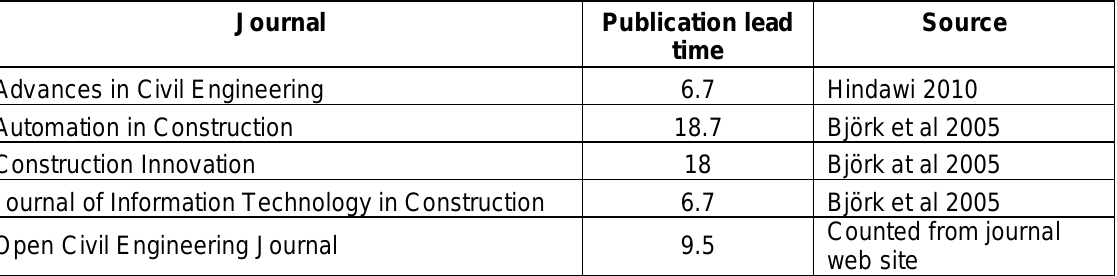
Table 6 Average lead times from submission to publication for some of the journals in